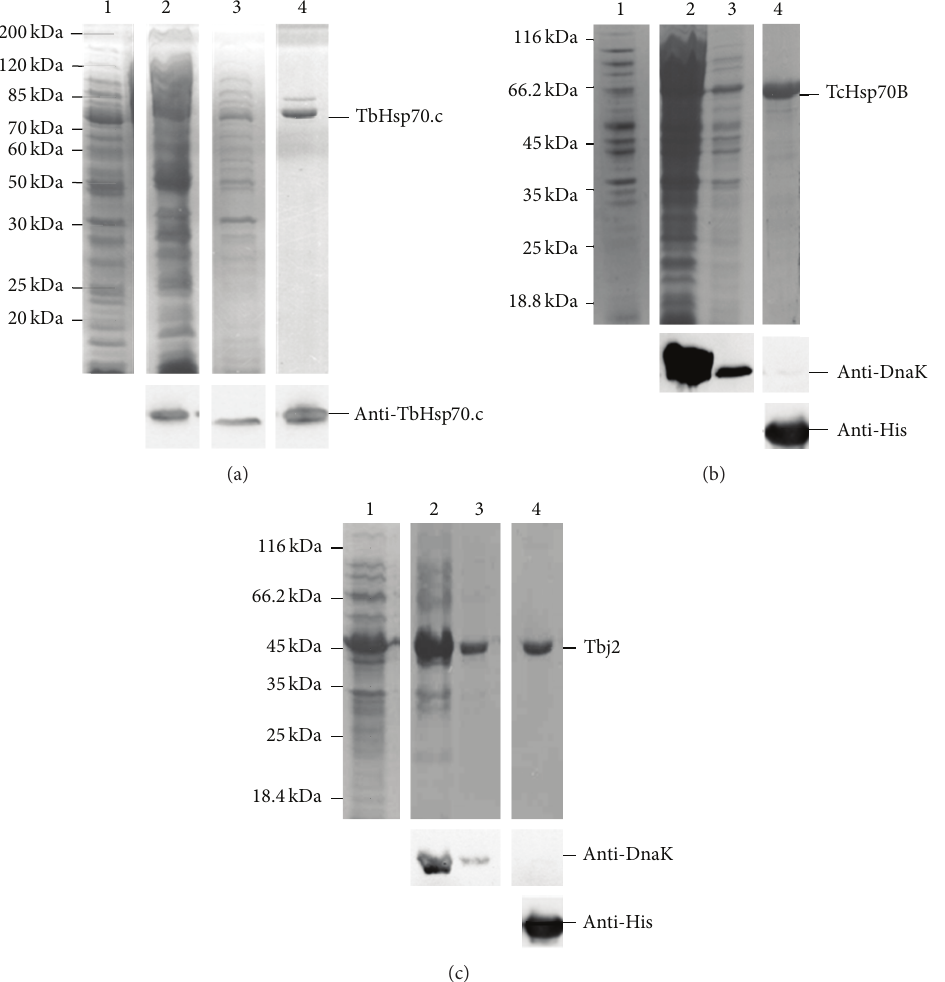
Figure 2: Expression and purification of recombinant TbHsp70.c, TcHsp70B, and Tbj2. (a) SDS-PAGE of a TbHsp70.c purification. Upper panel: Lanes 1 - E. coli BB1994 [pQE80TbHsp70.c] whole lysate 3hr post IPTG induction, 2 - fraction unbound to Ni-NTA column, 3 - wash using 20 mM imidazole, 4 - first TbHsp70.c elution (500mM imidazole). Lower panel: western analysis of TbHsp70.c at 73 kDa using